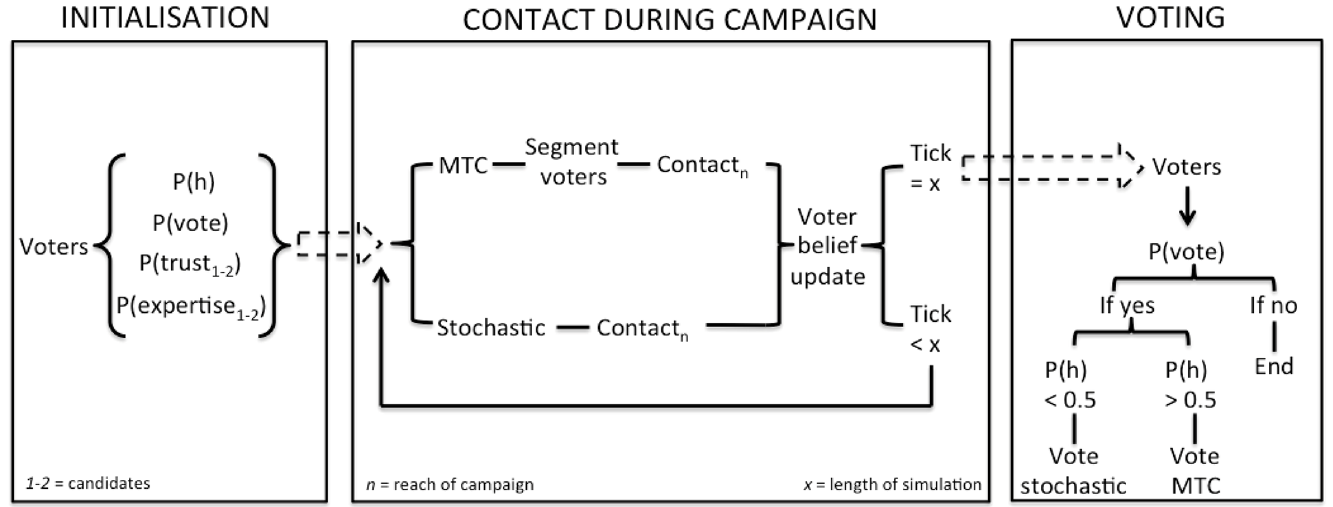
Fig 2. Model flow (spin-up phase, contact phase, and voting phase).